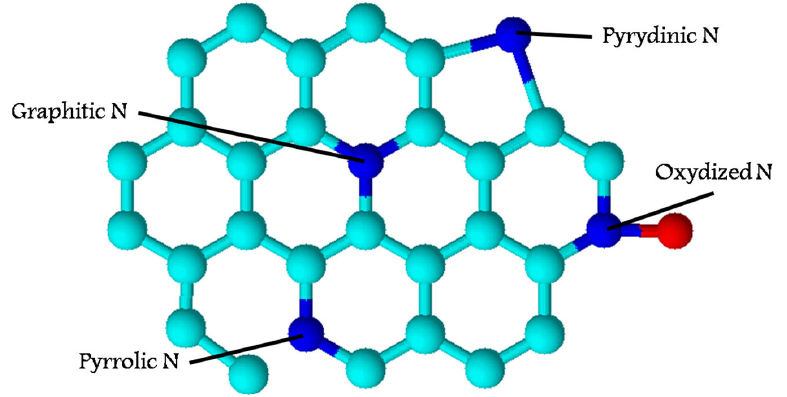
Figure 5. Overall structure of N ‐ doped carbon ‐ based electrocatalyst. Summarized from [69,70,73,77–85].